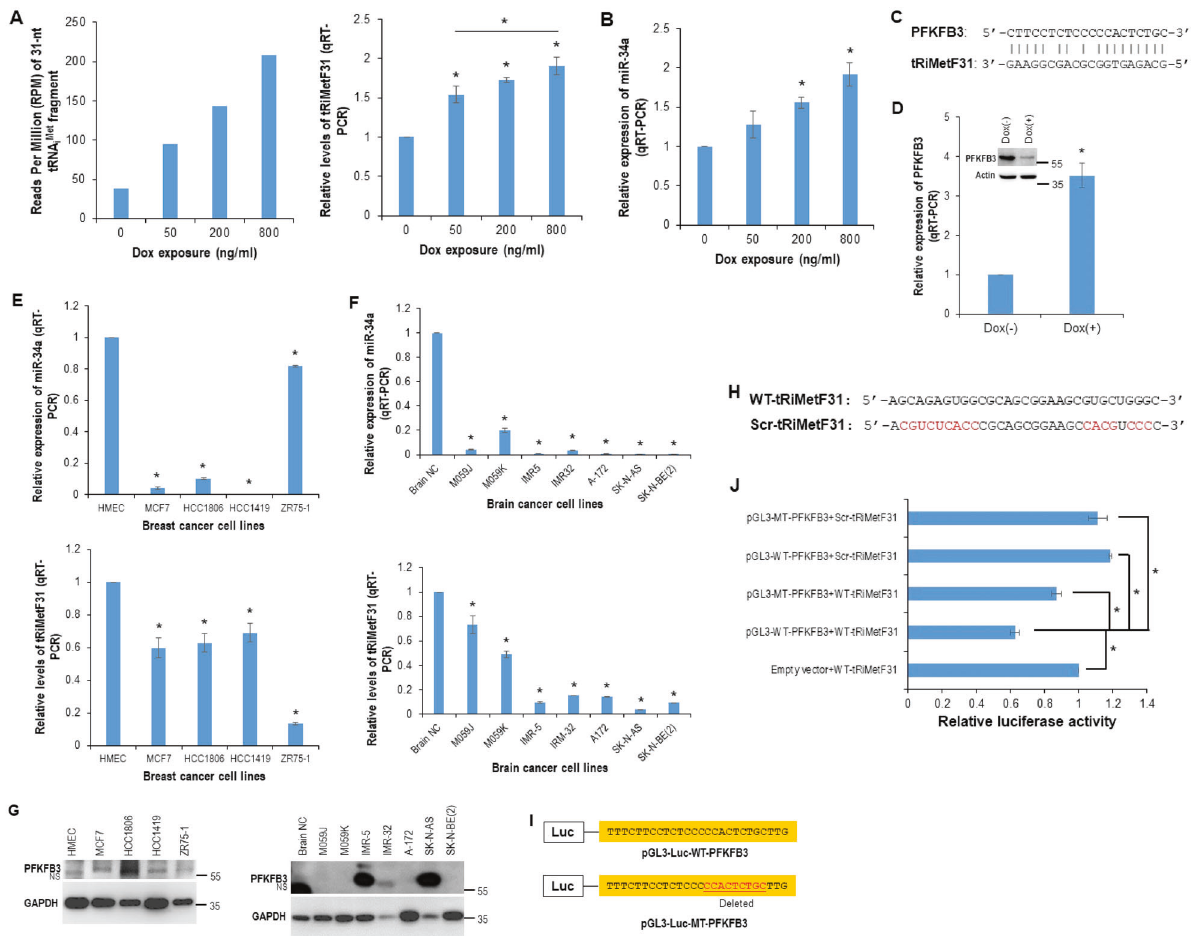
Fig. 1 PFKFB3 is a direct target of tRNA iMet -derived fragment tRiMetF31. A Total RNA isolated from Dox-inducible miR-34a-expressing breast cancer HCC1806 cells was subjected to small non-coding RNA-Seq and qRT-PCR analysis of tRiMetF31, as detailed in the “ Materials and methods ” . B Total RNA isolated from Dox-inducible miR-34a-expressing breast cancer HCC1806 cells was subjected to qRT-PCR analysis of miR- 34a. C Predicted binding motif between tRiMetF31 and PFKFB3 3 ’ UTR. D PFKFB3 protein and mRNA levels in Dox( − ) and Dox( + ) HCC1806 cells were measured by Western blot analysis and qRT-PCR. E , F Total RNA isolated from the indicated breast ( E ) and brain ( F ) cancer cell lines was subjected to qRT-PCR analyses using a primer set for either miR-34a or tRiMetF31. G Whole cellular lysates prepared from either breast (left panel) or brain (right panel) cancer cell lines were subjected to Western blot analysis using antibody against PFKFB3. H Sequences of wild-type and scrambled tRiMetF31 used in the luciferase assay. I Sequences of wild-type and mutant PFKFB3 luciferase reporters used in the